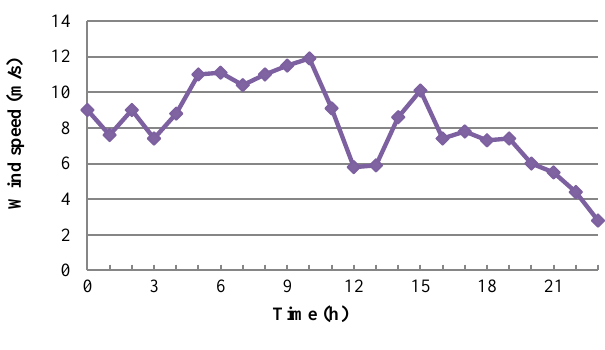
Figure 4. Measured wind speed